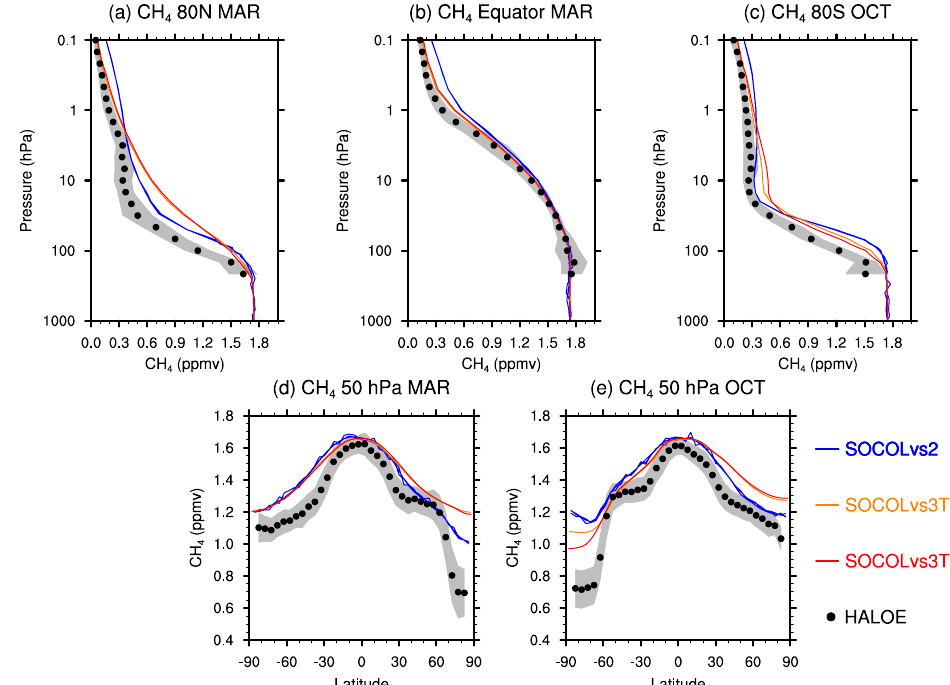
Fig. 6. Comparison of climatological (1992–2001) zonal-mean CH 4 mixing ratios (ppmv) from SOCOL and from HALOE for the same equivalent latitude. Upper panels: vertical profiles at (a) 80 ◦ N, March; (b) 0 ◦ , March; and (c) 80 ◦ S, October. Lower panels: meridional cross-section at 50hPa in (d) March and (e) October. The grey shaded areas indicate the HALOE standard deviation ( ± 1 σ